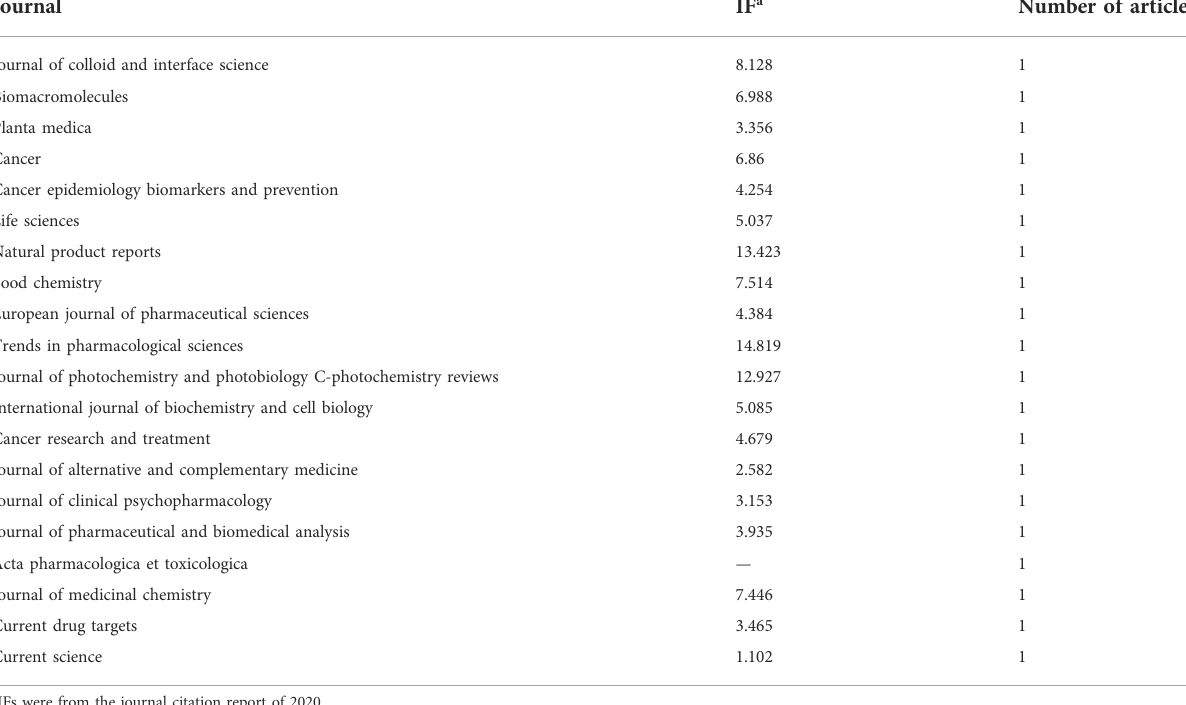
(Figure 6). The size of the circle indicates the number of occurrences of keywords (Wu, et al., 2021). Circles representing keywords such as curcumin , NF-kappa B